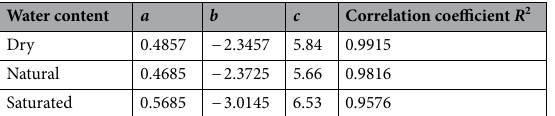
Table 2. Peak stress and loading pressure fitting coefficient of different samples.